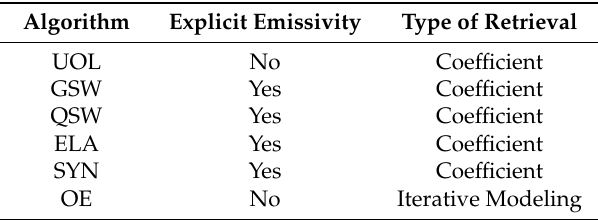
Table 1. Summary of the TIR Algorithms.